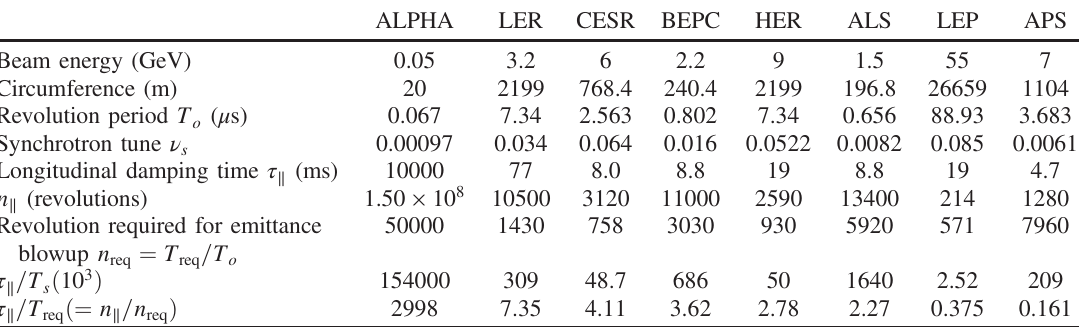
TABLE I. Properties of various electron or positron rings, ALS at LBL, BEPC at IHEP, LER and HER of PEP II at SLAC, CESR at Cornell, APS at ANL, and LEP at CERN, showing in particular the longitudinal damping time τ ∥ ,